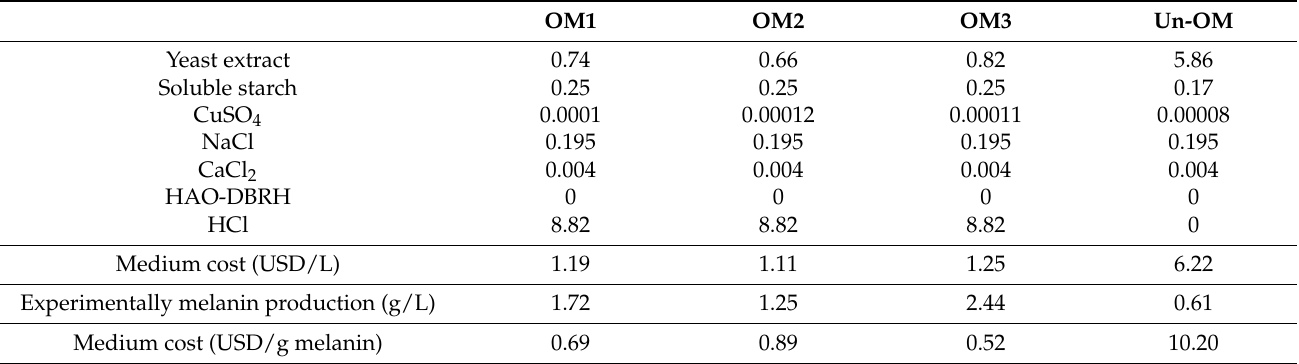
Table 6. Comparison of medium